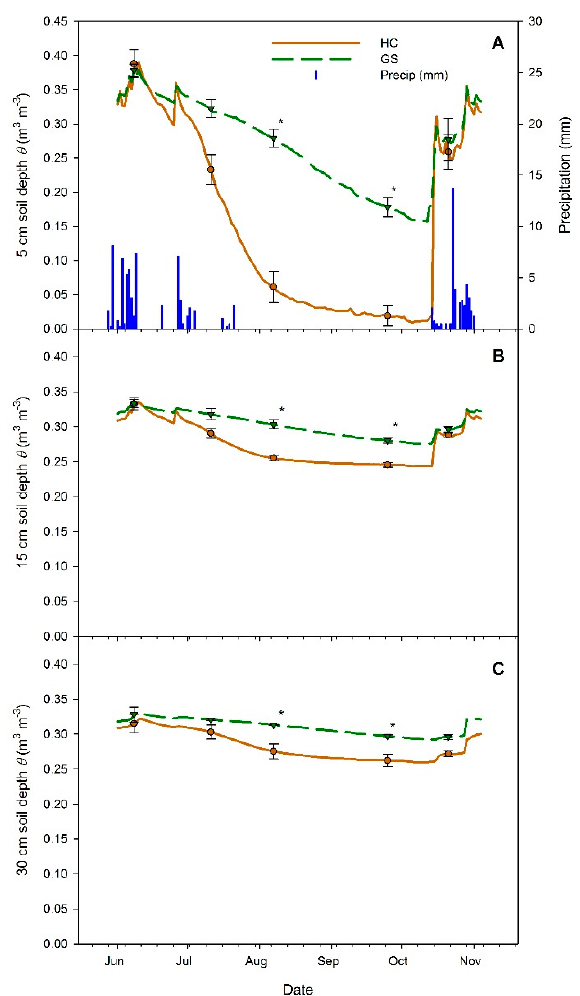
Figure 2. Volumetric soil moisture content ( θ ) of both vegetative competition treatments (high competition (HC) = solid brown lines, circles; glyphosate-sprayed (GS) = dashed green lines, triangles) at 5 ( A ), 15 ( B ) and 30 cm ( C ) depths, and daily precipitation totals (A, vertical bars on the x-axis) during the 2012 growing season. Points with vertical error bars indicate dates where seedling physiological measurements were performed, as well as seedling planting in June. Points with asterisks (*) indicate a significant difference between HC and GS treatments for that date ( α = 0.05, n = 3). Precipitation data from 9–18 June are missing due to weather station damage.